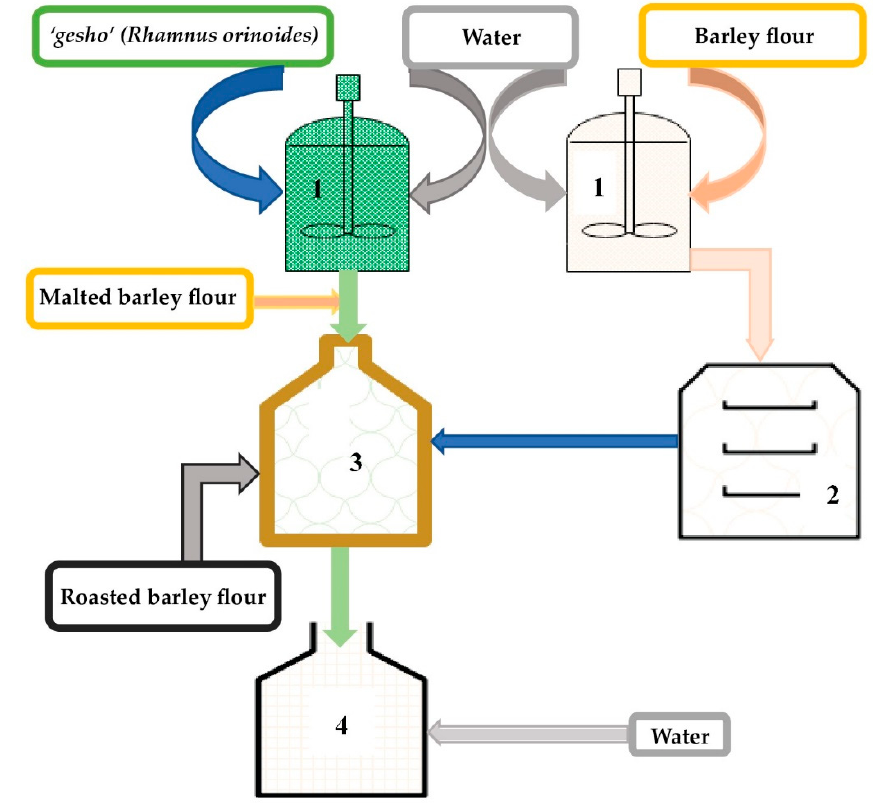
Figure 2. Korefe production process flow diagram: ( 1 ) mixer, ( 2 ) baking oven, ( 3 ) primary fermentation tank, ( 4 ) secondary fermentation